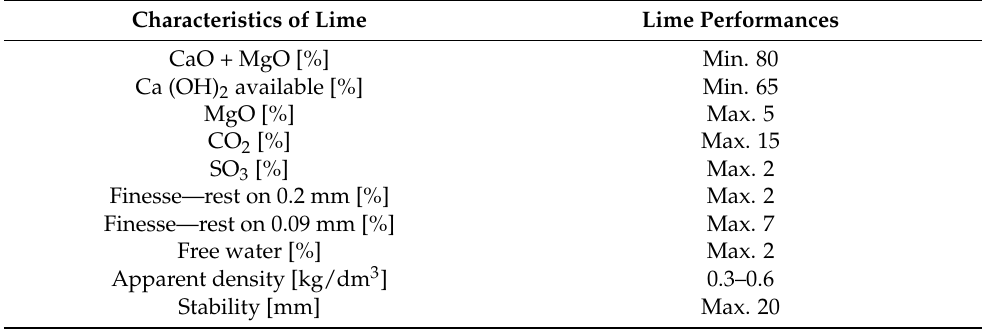
Table 2. Essential characteristics and performance of lime.